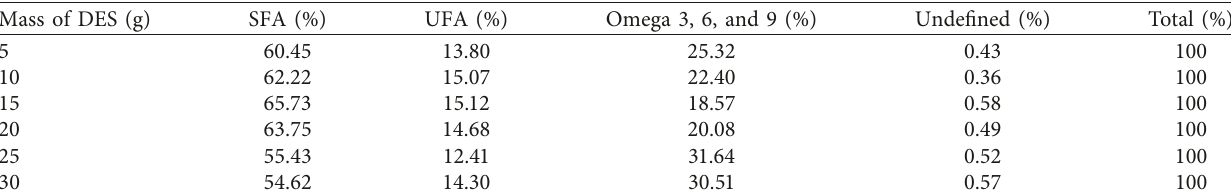
Figure 7: The dependence of omega FA and non-omega FA in the content of DES: (a) in liquid layer and (b) in crystal solid. Table 8: Fatty acid compositions of crystal